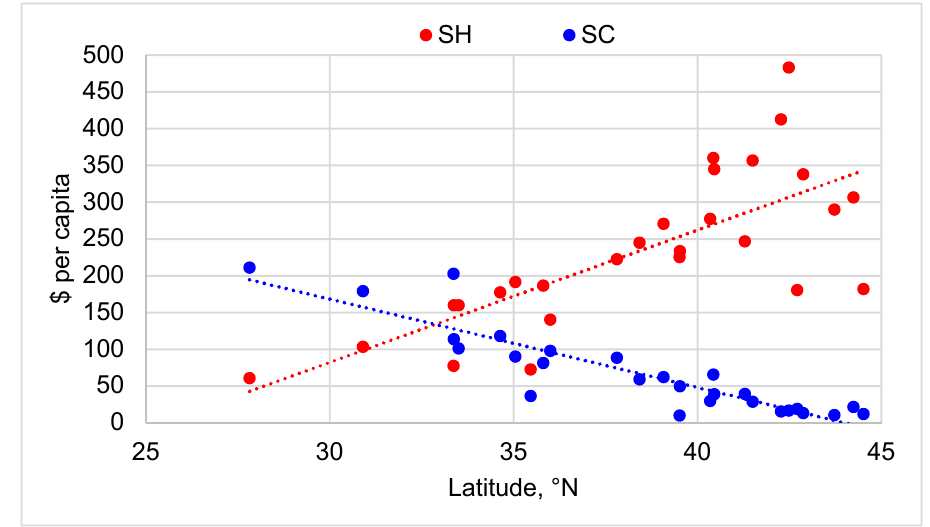
Figure 3. Residential per capita space heating (SH) and space cooling (SC) expenditure versus population centroid latitude, for the 27 states and state groups.